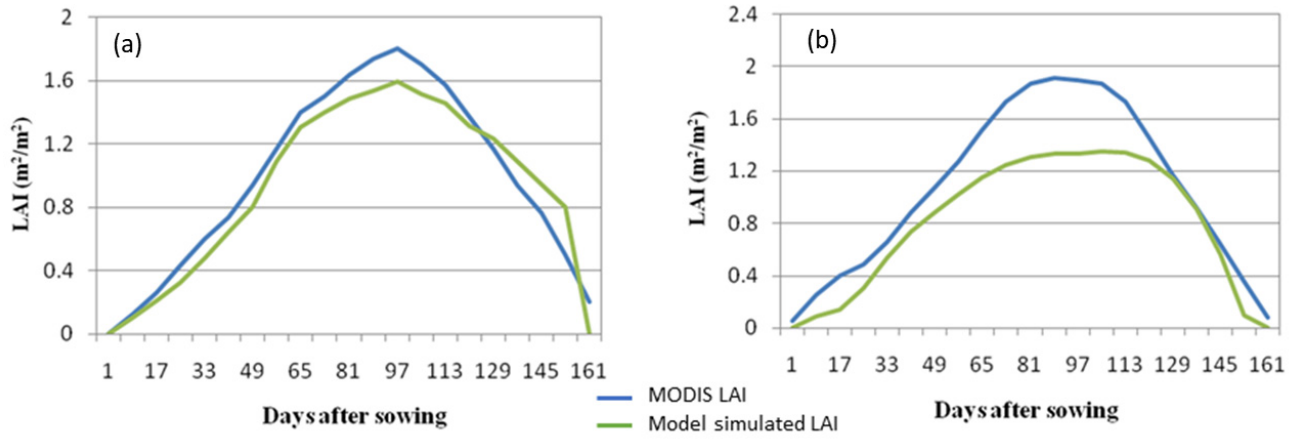
Figure 4. Calibration and validation plots ( a ) calibration plot for 2007–2008 crop season; ( b ) valida- tion plot for 2008–2009 crop